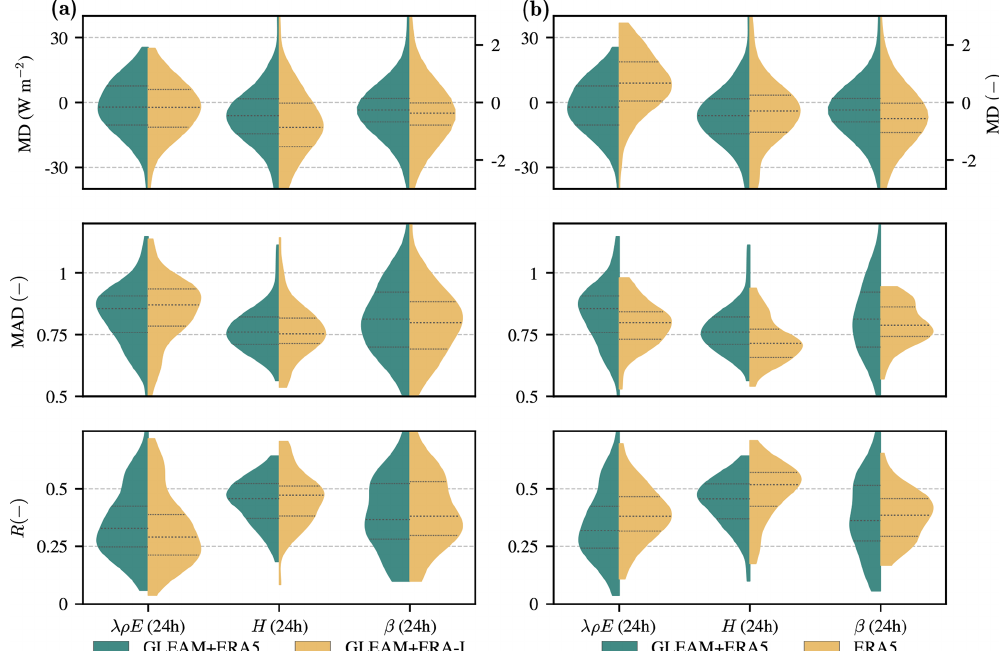
Figure 4. Violin plots of temporal validation statistics of the surface latent heat flux ( λρE ), surface sensible heat flux ( H ), and Bowen ratio ( β ) from GLEAM+ERA5, GLEAM+ERA-I, and ERA5. Panel (a) compares the violin plots from GLEAM+ERA5 and GLEAM+ERA-I and (b) compares the violin plots from GLEAM+ERA5 and ERA5. Statistics are calculated against in situ eddy-covariance measurements at daily temporal resolution. Violin plots represent the distribution of the individual validation statistics with indication of the median and interquartile range and are calculated using a kernel density estimation approach. Statistics include the MD (raw in situ time series from 143 sites as reference), MAD (anomaly in situ time series from 77 sites as reference), and R (anomaly in situ time series from 77 sites as reference). The distribution of the MD of β is plotted on the right y